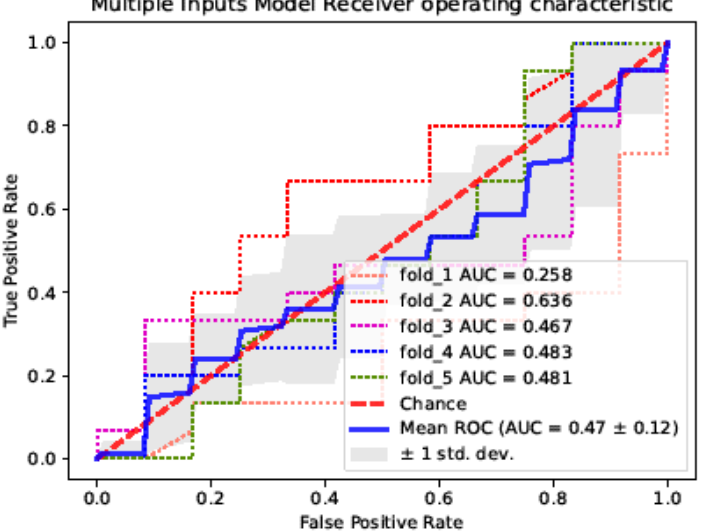
Figure 8. ROC curve of the multi-image input processing network collateral circulation evaluation model.